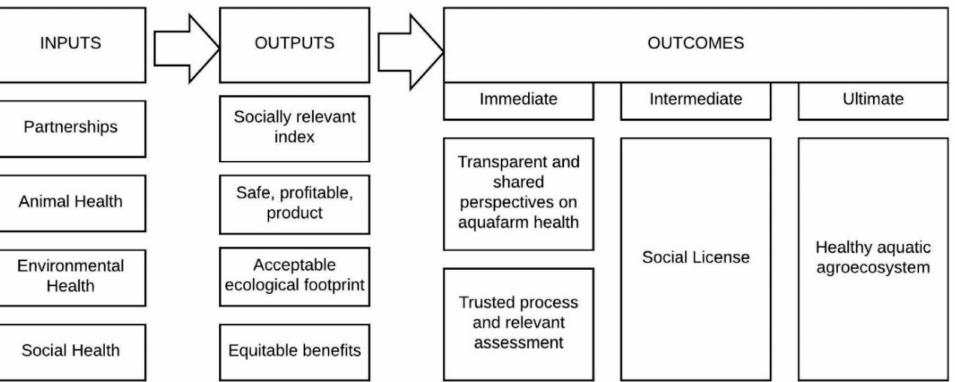
Figure 1. Logic model for an aquaculture well-being index.